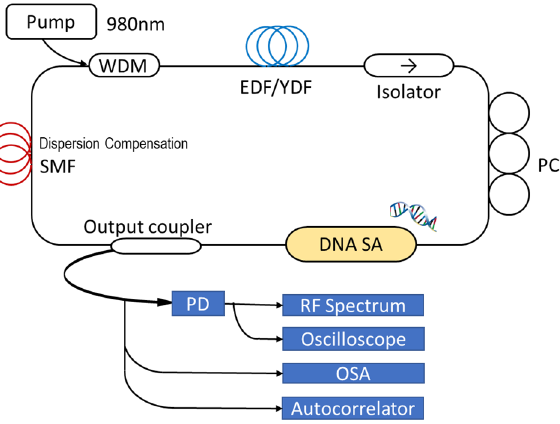
Figure 3. Experimental setup of the passively mode-locked fiber laser using liquid DNA as the